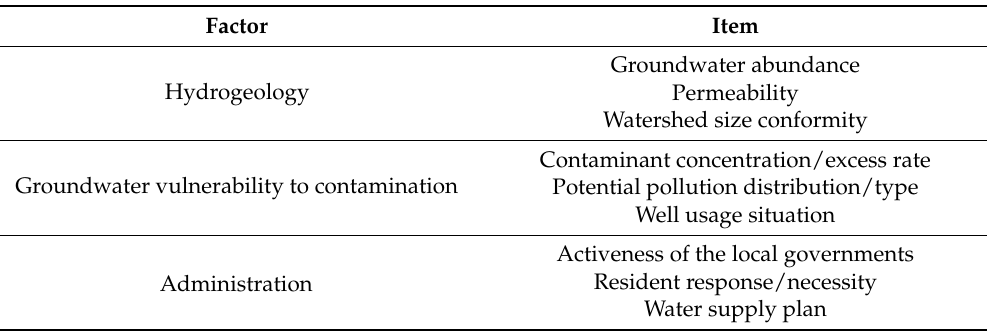
Table 6. Criteria for pilot project